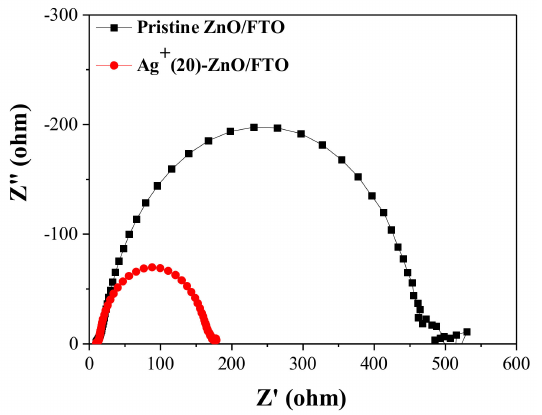
Figure 8. Nyquist plots of EIS spectra for the DSCs with the pristine ZnO/FTO and the Ag + (20)– ZnO/FTO, measured under illumination (AM 1.5 condition).